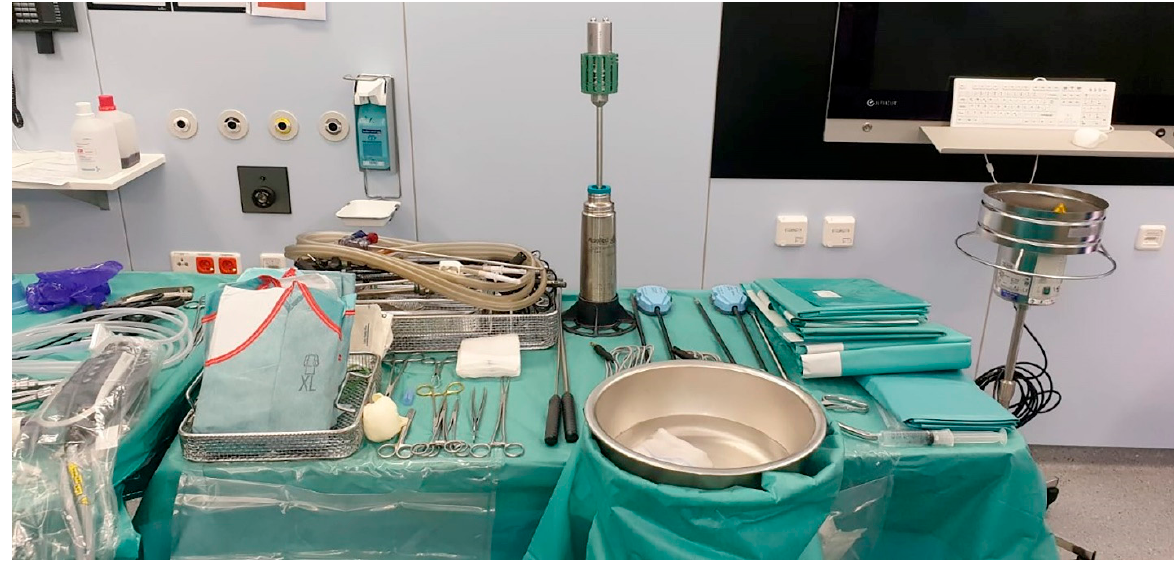
Figure 3. Operation settings and instruments.